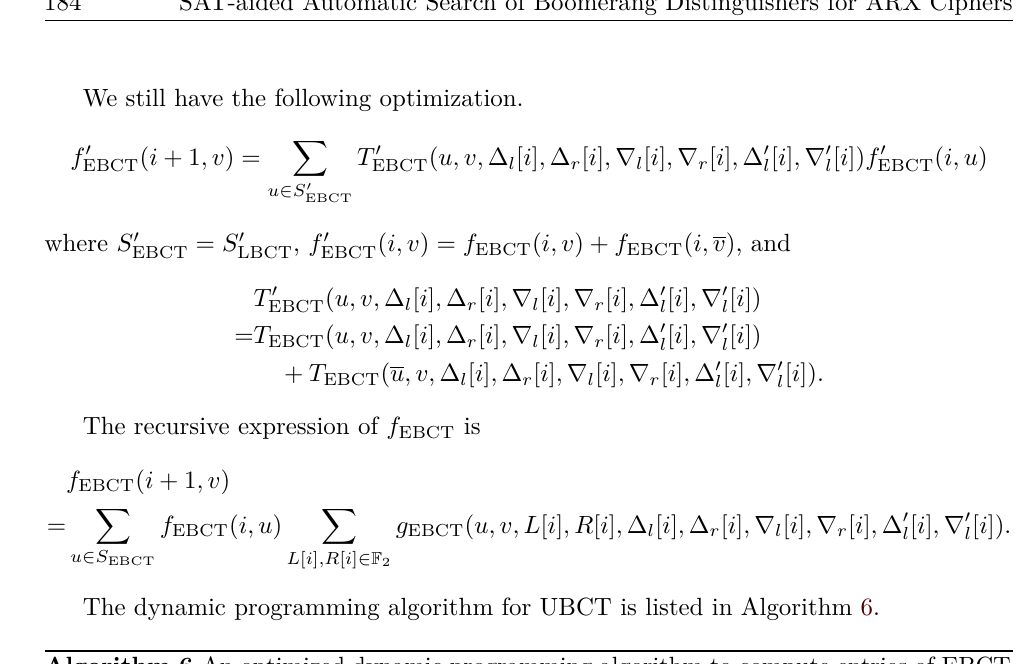
Algorithm 6 An optimized dynamic programming algorithm to compute entries of